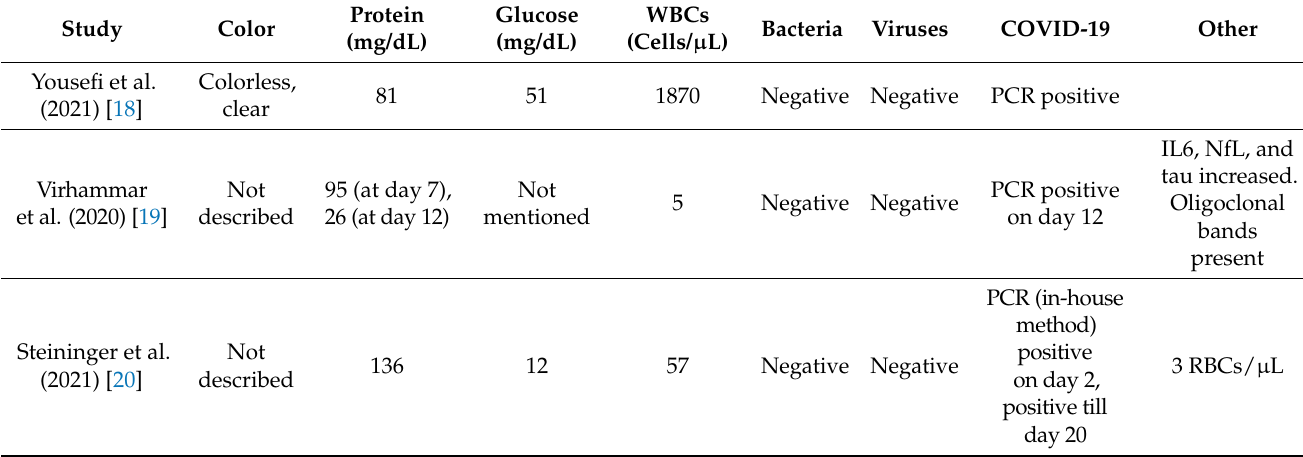
Table 3. CSF changes in cases with confirmed COVID-19 CSF